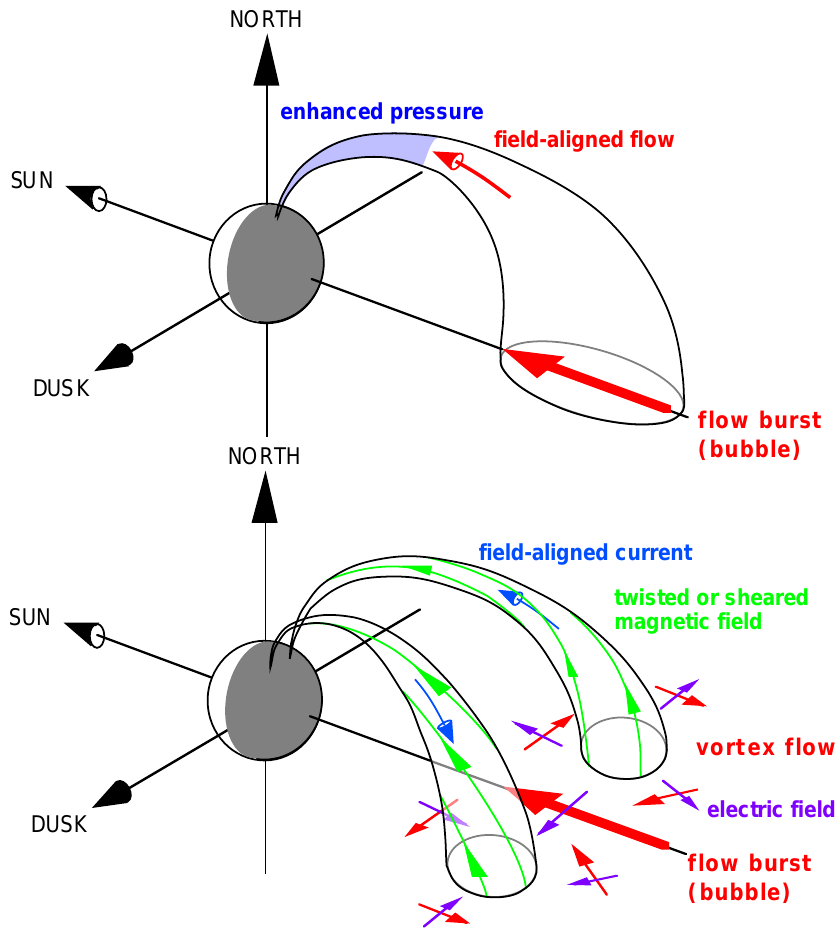
Fig. 19. Schematic illustrating the mechanisms of pressure enhancement from the slow-down of field-aligned flow near the Earth (top) and field-aligned current generation (bottom). When the bubble moves earthward, field lines that are located more earthward become pushed outward, out of the way of the bubble. This leads to a vortex flow outside the bubble, causing a twist or shear in the magnetic field, which corresponds to the presence of field-aligned currents of region-1